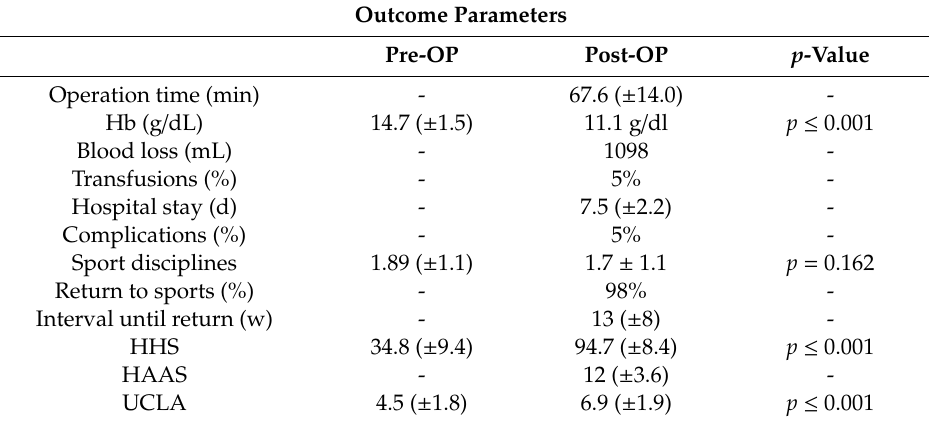
Table 2. Outcome parameters. Values are depicted as arithmetic mean and standard deviation unless marked otherwise. Outcome Parameters Pre-OP Post-OP p